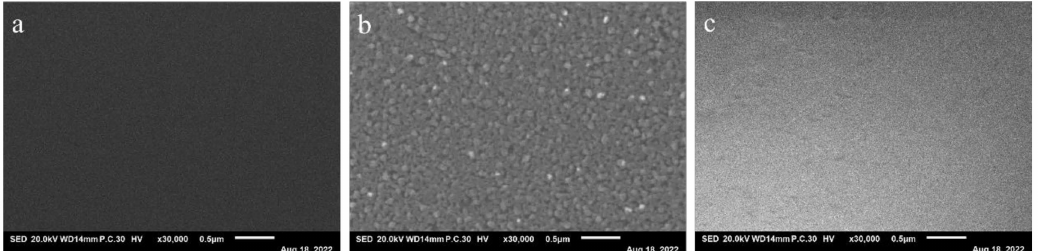
Figure 4. SEM images of the inner surface of microchamber with 30000 × magnification. ( a ) Before drug prepositioning. ( b ) After Ampicillin prepositioning by freeze-drying. ( c ) After Kanamycin prepositioning by